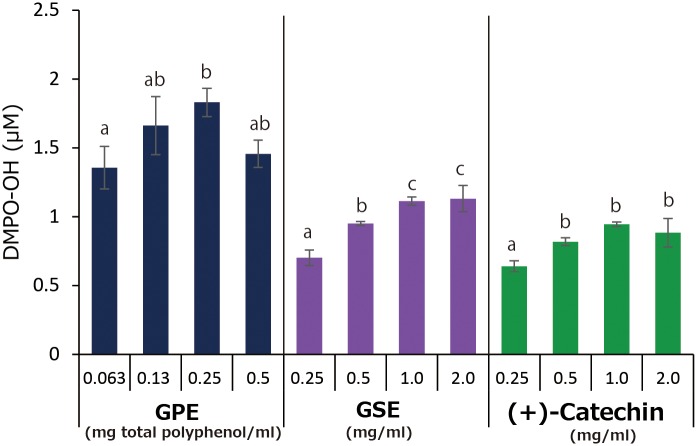
Concentration effect of GPE, GSE, and (+)-catechin on •OH (expressed as DMO-OH) generation during LED-light irradiation for 1 min.Each value represents the mean with standard deviation (n = 3). Significant differences (p<0.05) in each group are denoted by different alphabetical letters.